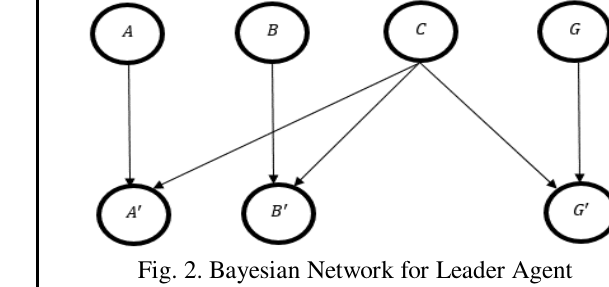
Fig. 2. Bayesian Network for Leader